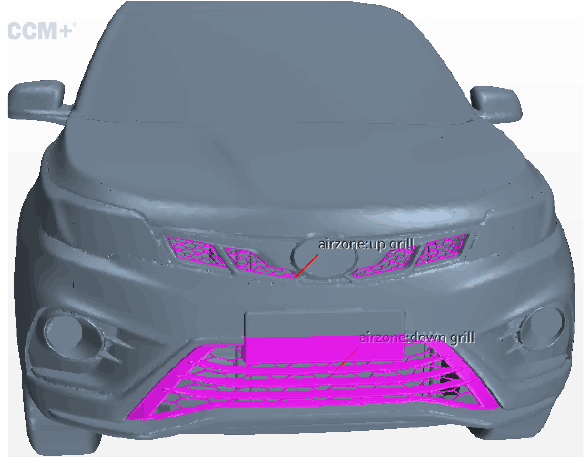
Figure 7. The front view of vehicle.